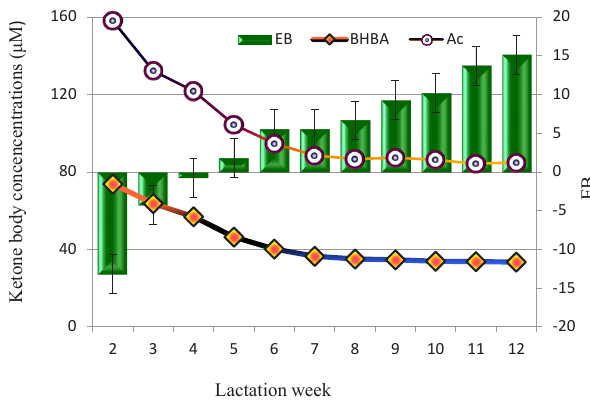
Figure 2. The relationship between milk BHBA and acetone concentration with energy balance along with lactation week (EB, energy balance; Ac, acetone; BHBA, β -hydroxybutyrate). The bar graph represents the EB values and line graphs represent the ketone body concentrations.